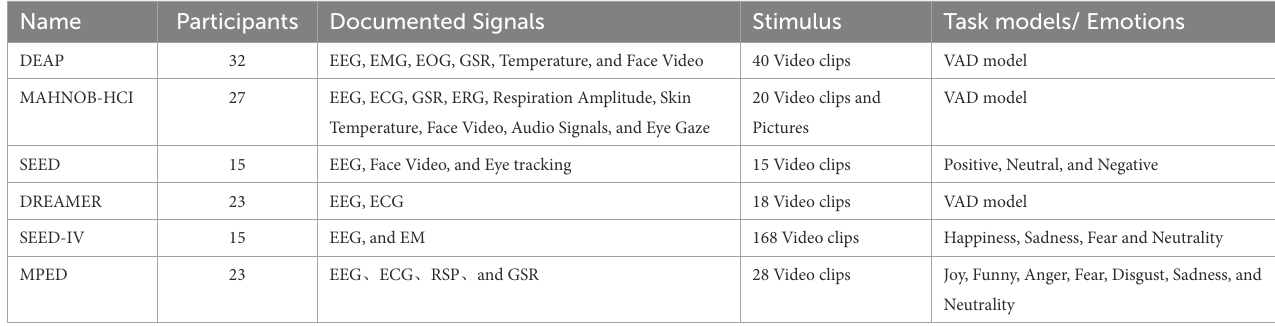
TABLE 1 Description of public